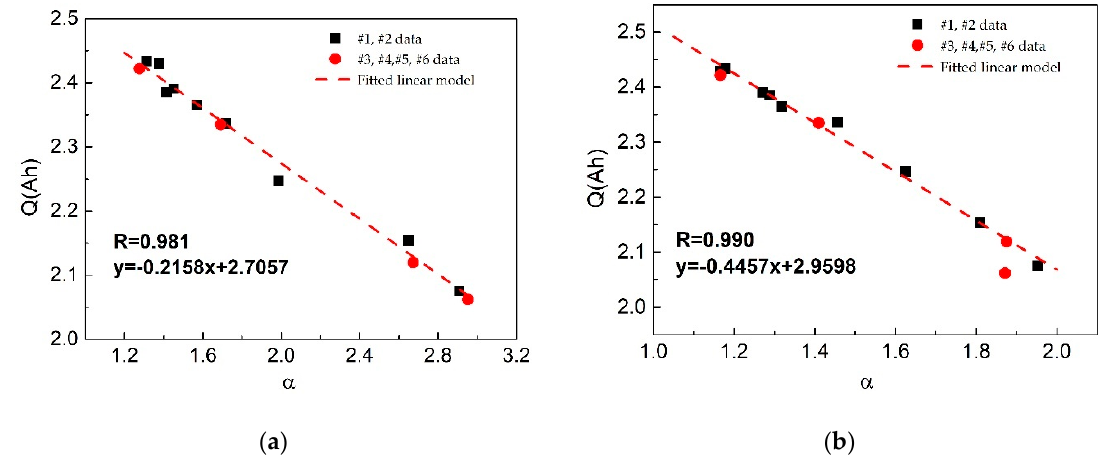
Figure 14. Fitted linear model of α -based capacity estimation method. ( a ) 70% SOC under charging condition; ( b ) 40% SOC under discharging condition.